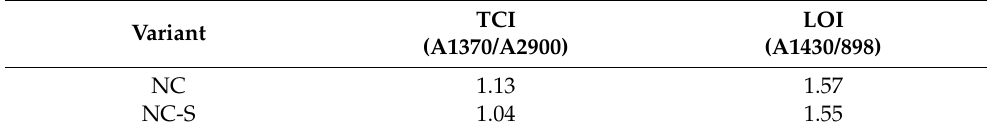
Table 3. Crystallinity of nanocellulose.